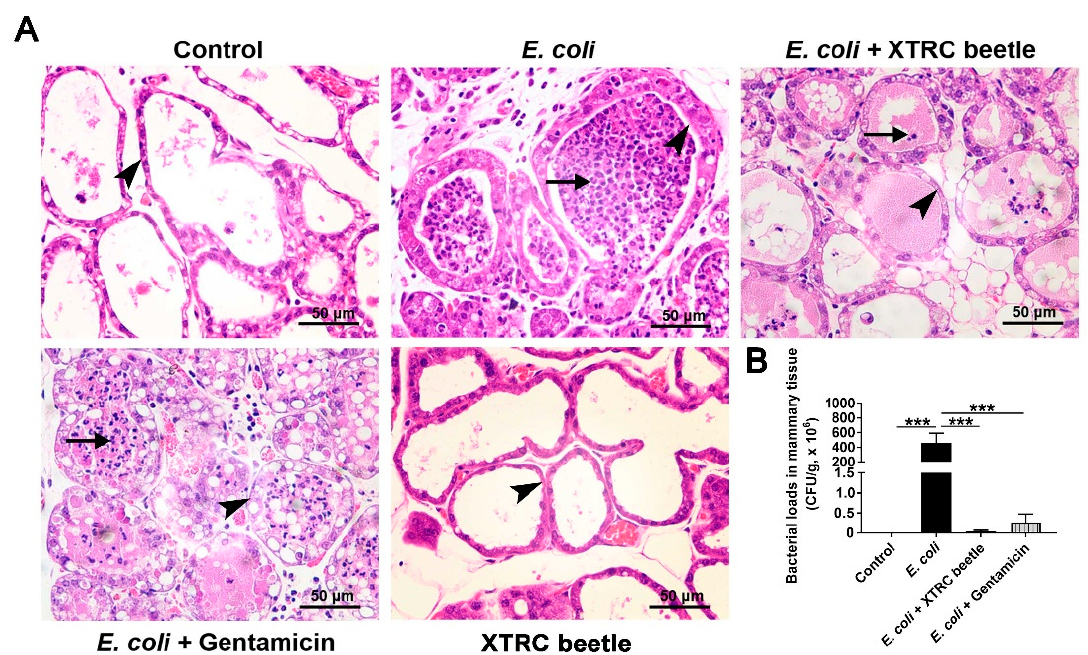
Figure 1. Effects of Z. morio hemolymph on mice mammary gland injury. ( A ) Histopathologic sections of mammary tissues. Short arrows and long arrows indicate neutrophils infiltration in acinar cavity and the thickening of mammary acinar walls, respectively. Scale bars, 50 µ m. ( B ) Bacterial burden in the mammary tissues. XTRC beetle stands for Z. morio hemolymph-treatment. The data from each group are presented as the mean ± SEM ( n = 8 per group). *** p < 0.001.